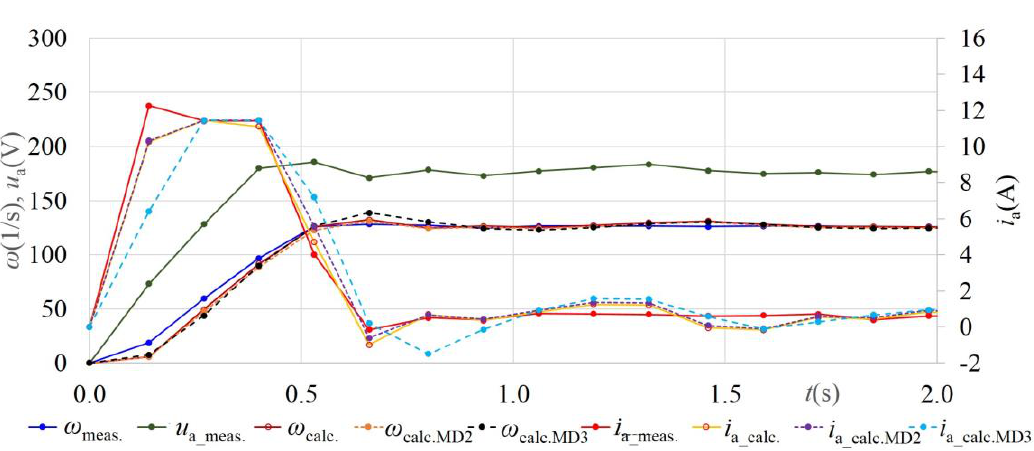
Figure 13. The simulated motor speed and current using R MD1 , R MD2 , and R MD3 for MD1 values.